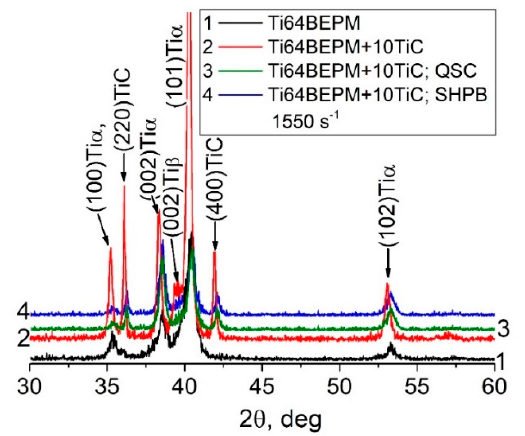
Figure 7. The X-ray diffraction patterns of (curve 1) Ti64BEPM, and Ti64BEPM + 10TiC in (curve 2) as-sintered state, and after (curve 3) QSC ( 𝜀(cid:4662) = 10 − 3 s − 1 ) and (curve 4) high-strain-rate SHPB ( 𝜀(cid:4662) = 1550 . s − 1 ) tests.